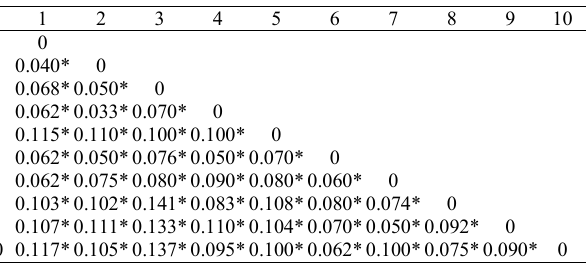
0.002 between “CII - end of 2003” and “CII - end of 2005”) (Table 7), confirming the F obtained in Table 3. ST